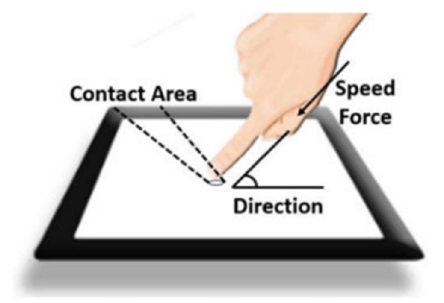
Figure 8. Three factors leading to unstable force-voltage responsivity [42].